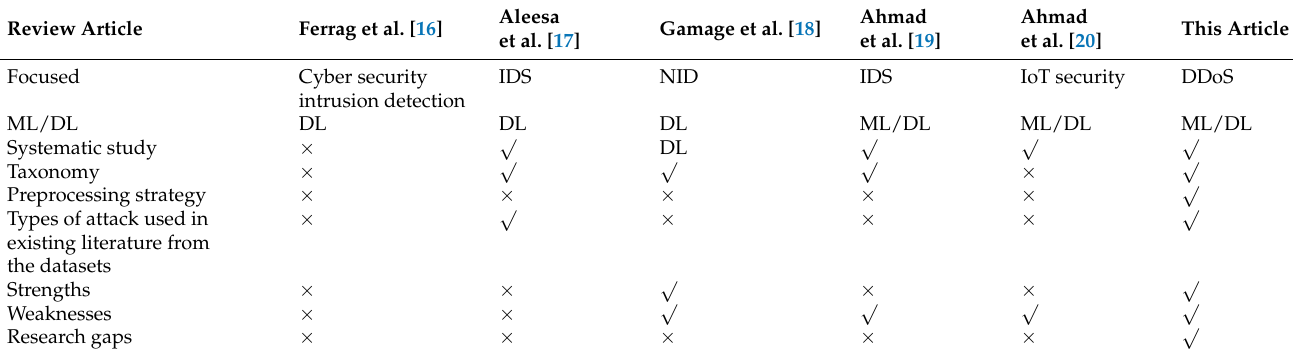
Table 1. Comparison of various research papers in detail (